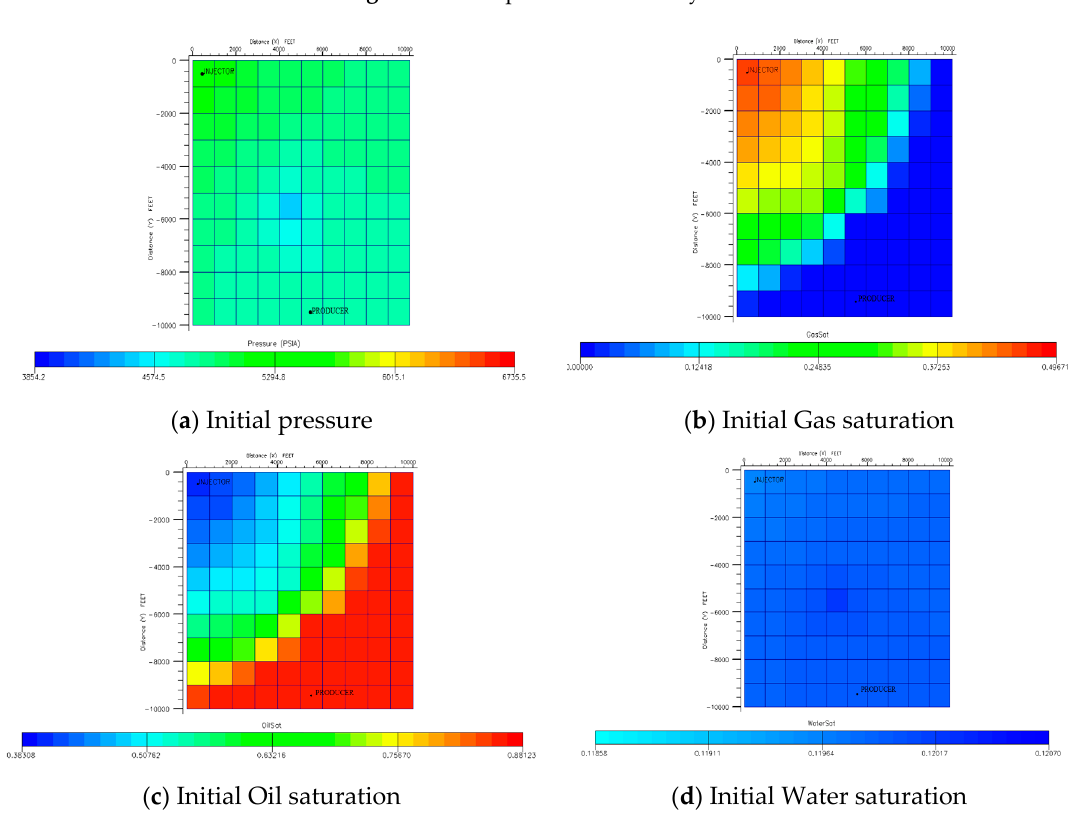
Figure 5. Description for case study 2. Table 2. Parameters used for metaheuristic algorithms on well placement